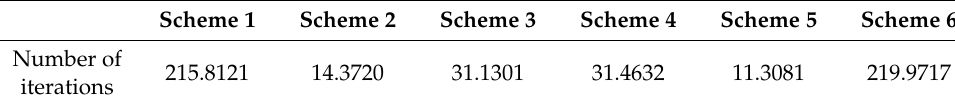
Table 7. The average number of iterations of proposed robust